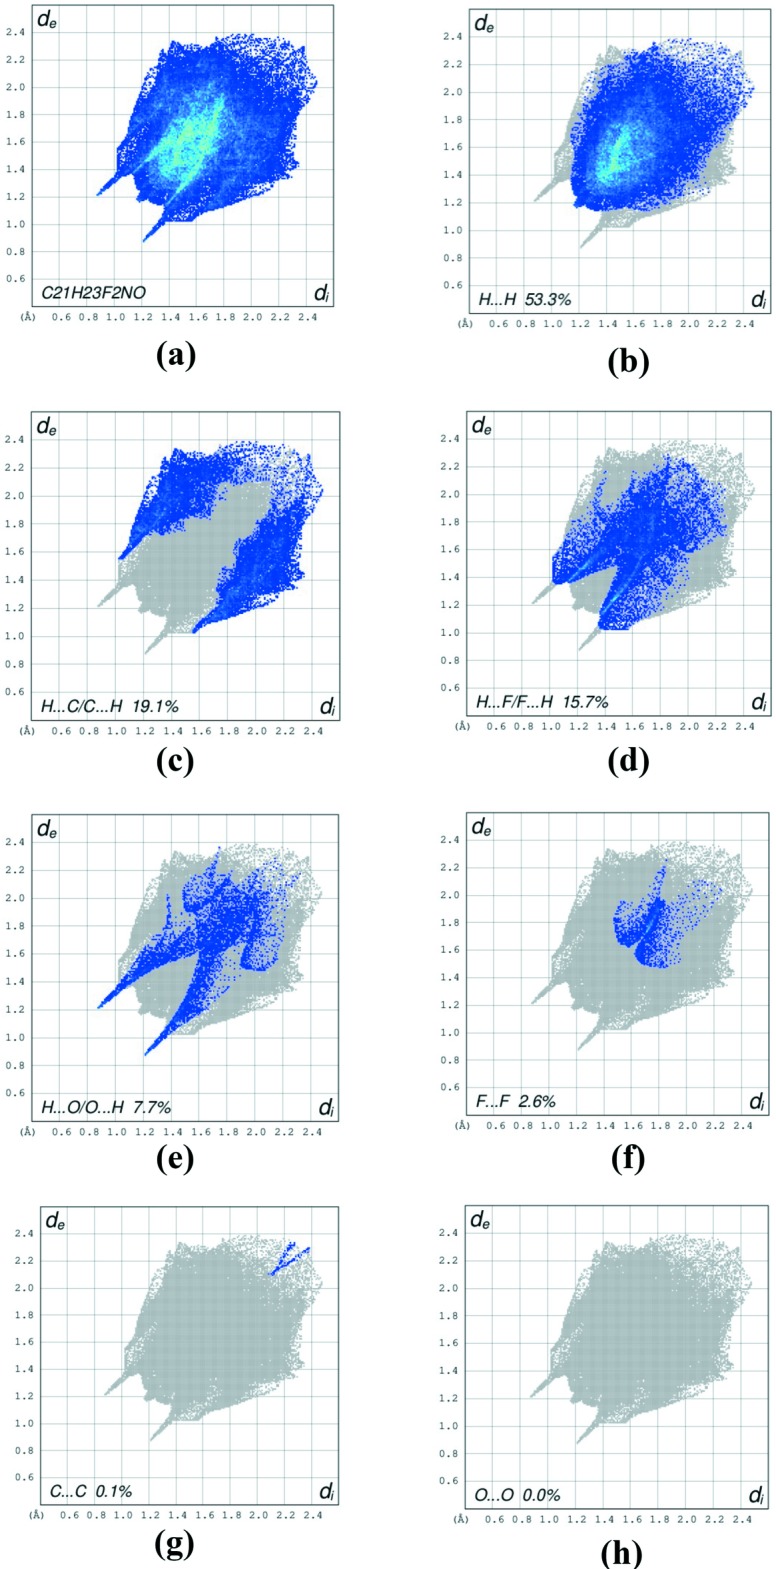
A view of the two-dimensional fingerprint plots for C21H23F2NO, showing (a) all inter­actions, and separated into (b) H⋯H, (c) H⋯C/C⋯H, (d) H⋯F/F⋯H, (e) O⋯H/H⋯O, (f) F⋯F, (g) C—C and (h) O⋯O inter­actions. The d
i and d
e values are the closest inter­nal and external distances (in Å) from given points on the Hirshfeld surface contacts.